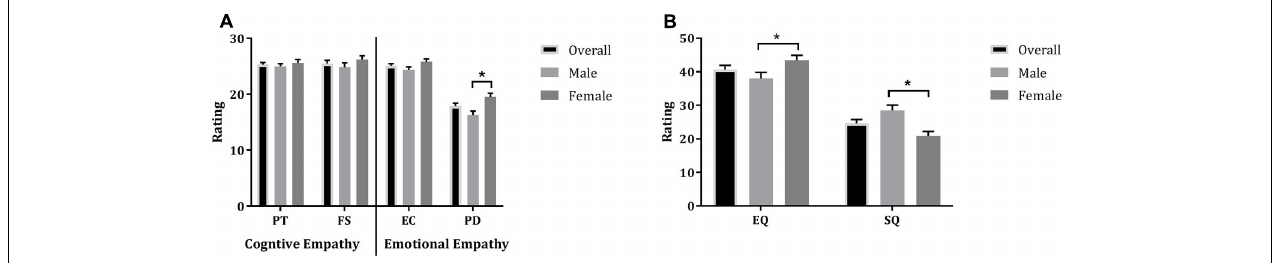
FIGURE 3 | Mean ( ± SE) of ratings of males, females, and both groups together (overall) on subscales of the Interpersonal Reactivity Index (A) and the Empathizing-Systemizing (EQ/SQ) questionnaire (B) ; PT, Perspective Taking; FS, Fantasy Scale; EC, Empathic Concern; PD, Personal Distress; ∗ indicates statistical significance at p = 0.05.